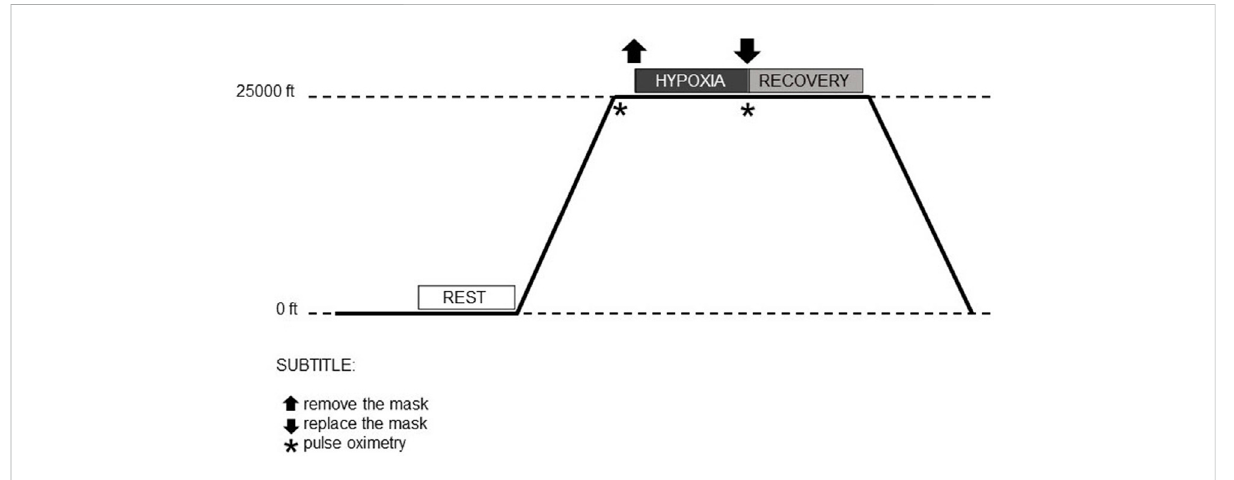
FIGURE 1 Moments of the fl ight simulation in the hypobaric